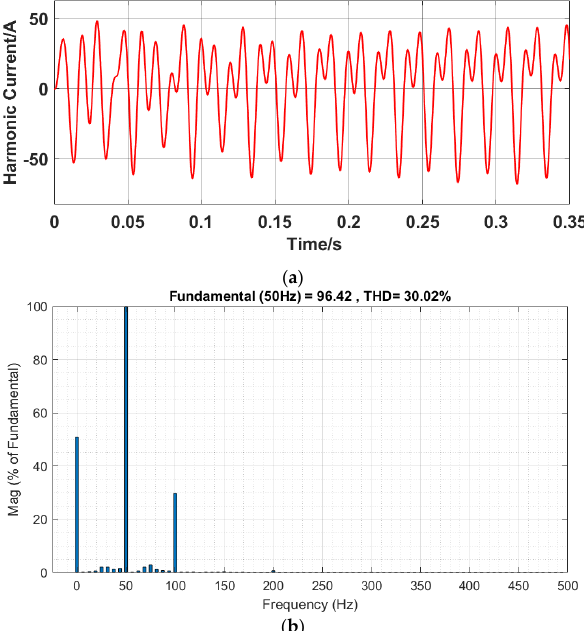
Figure 11. ( a ) Harmonic current without the suppressor. ( b ) FFT analysis of the bridge arm current without the suppressor.